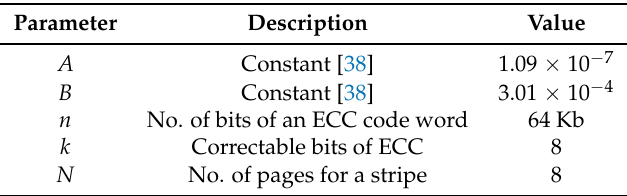
Figure 7. Comparison of UPER for mSAPL and eSAP. Table 3. Parameters of UPER